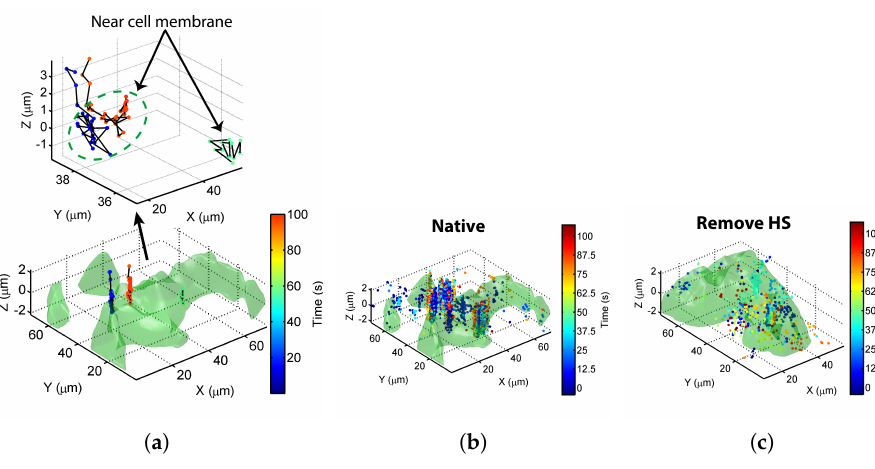
Figure 4. ( a ) three trajectories of TatP-QDs near a living HeLa cell (green) were color-coded to indicate their appearing times. The green profile denotes the cellular surface rendered from optical sectioning phase contrast images; ( b ) when duration was increased to acquire information on more approaching events, trajectory aggregates were observed at selected regions on a native HeLa cell. Each cluster contained up to 150 trajectories; ( c ) time-resolved location coordinates of TatP-QDs near a cell pretreated with HSase to cleave HS groups from membrane-bound